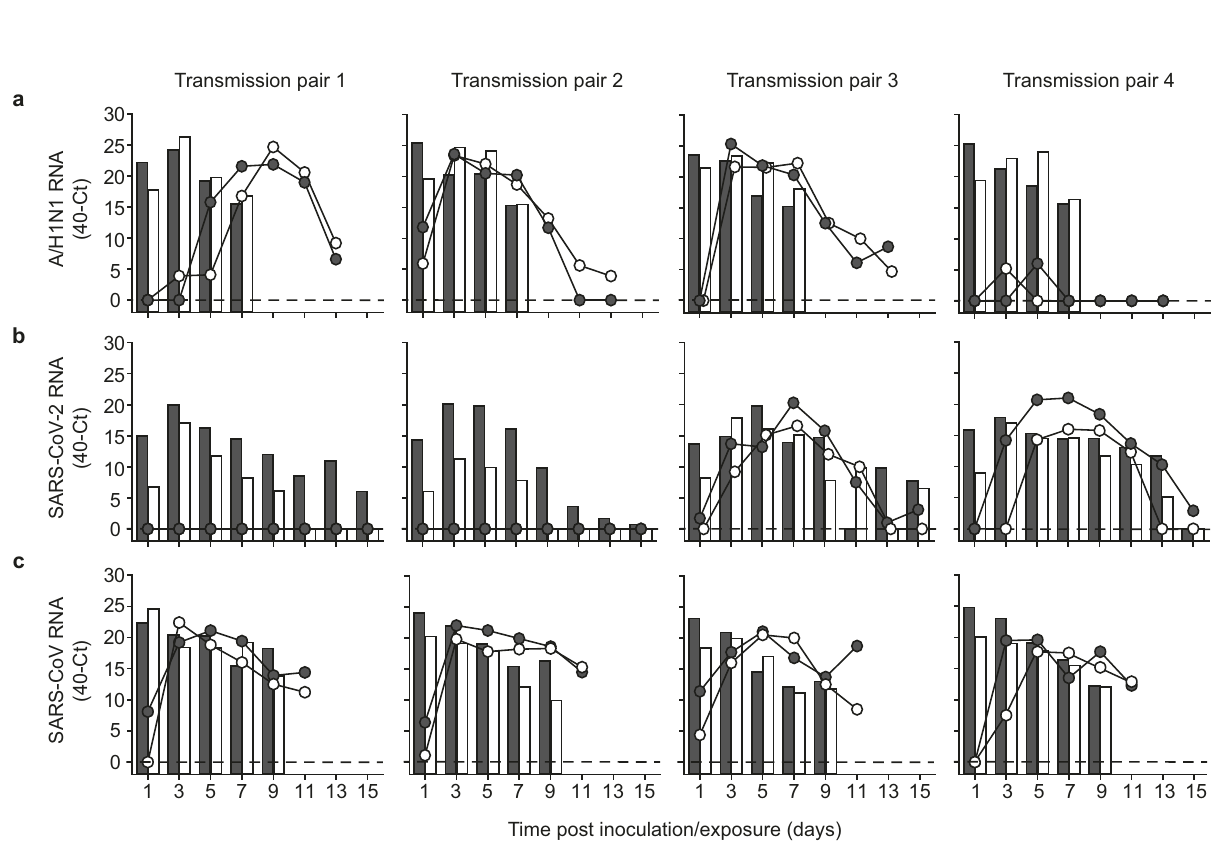
Fig. 2 Virus RNA shedding in ferrets. A/H1N1 ( a ), SARS-CoV-2 ( b ), and SARS-CoV ( c ) RNA were detected by qRT-PCR in the throat (gray) and nasal (white) swabs collected from a donor (bars) and recipient (circles) ferrets every other day. An individual donor-recipient pair is shown in each